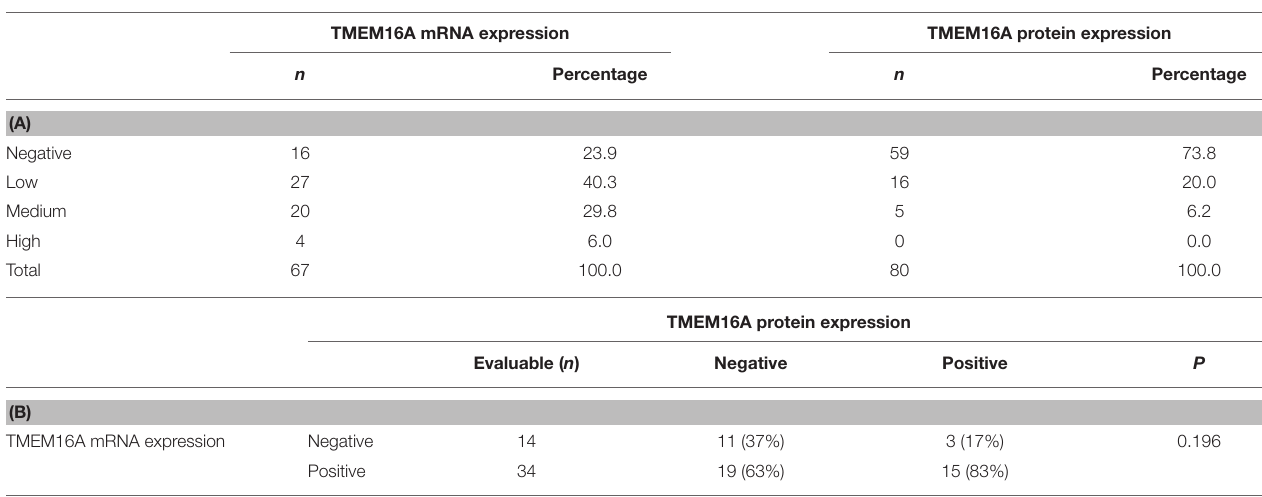
TABLE 2 | Analysis of TMEM16A mRNA and protein expression in